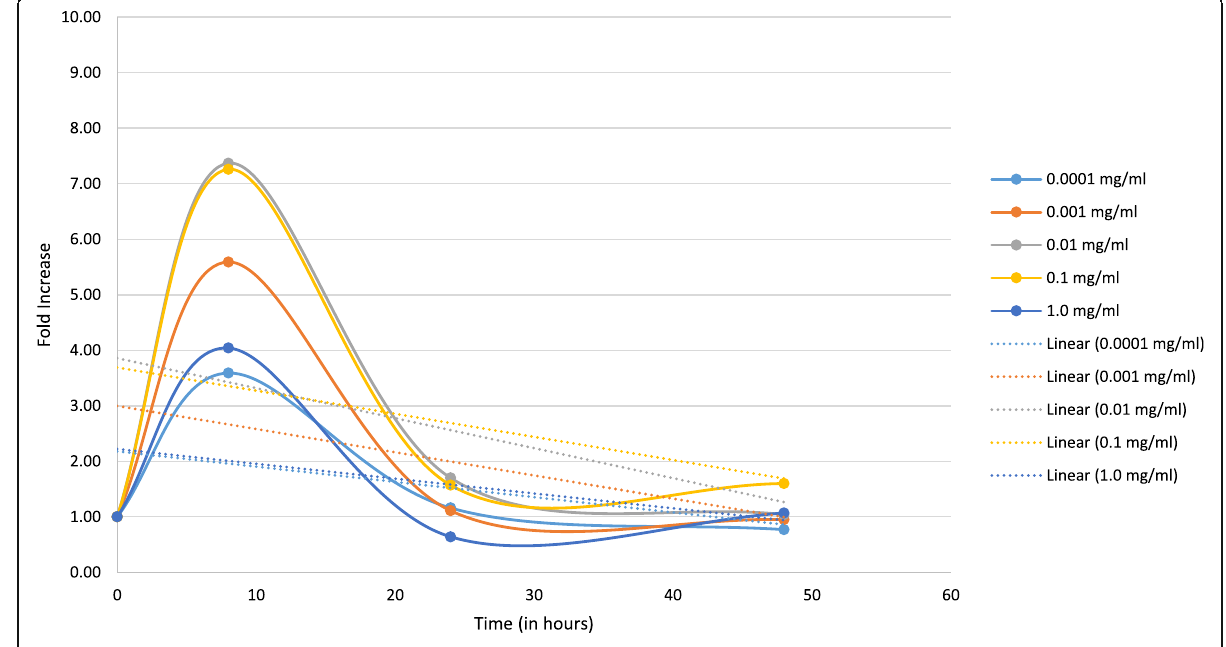
Fig. 6 Effect of StemForte Plus® on Telomerase Activity at different Time